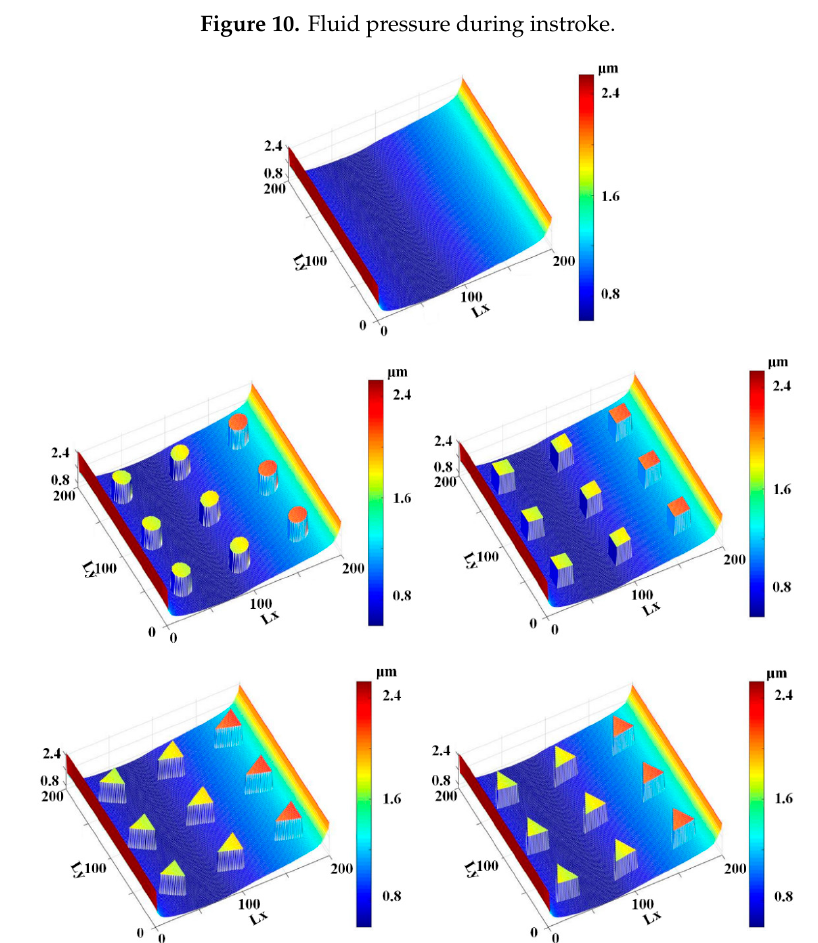
Figure 11. Film thickness during the outstroke.